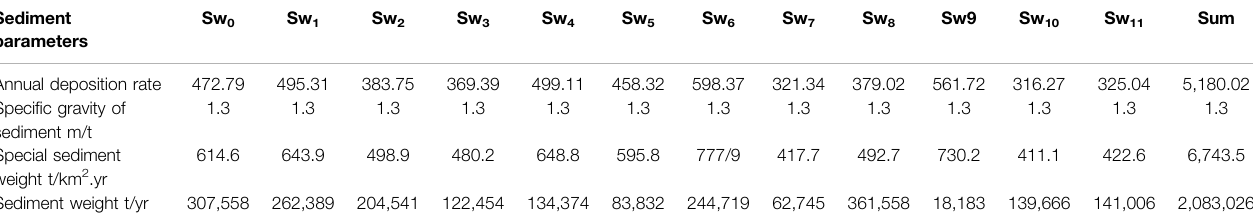
TABLE 8 | The sedimentation rate of hydrological units of the Anzali catchment based on the MPSIAC model. Sediment